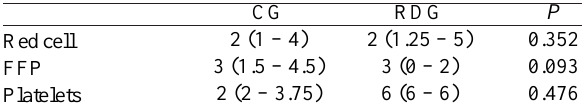
Table 4. Transfusion of red blood cells, fresh frozen plasma and platelets units in the post-operative period.